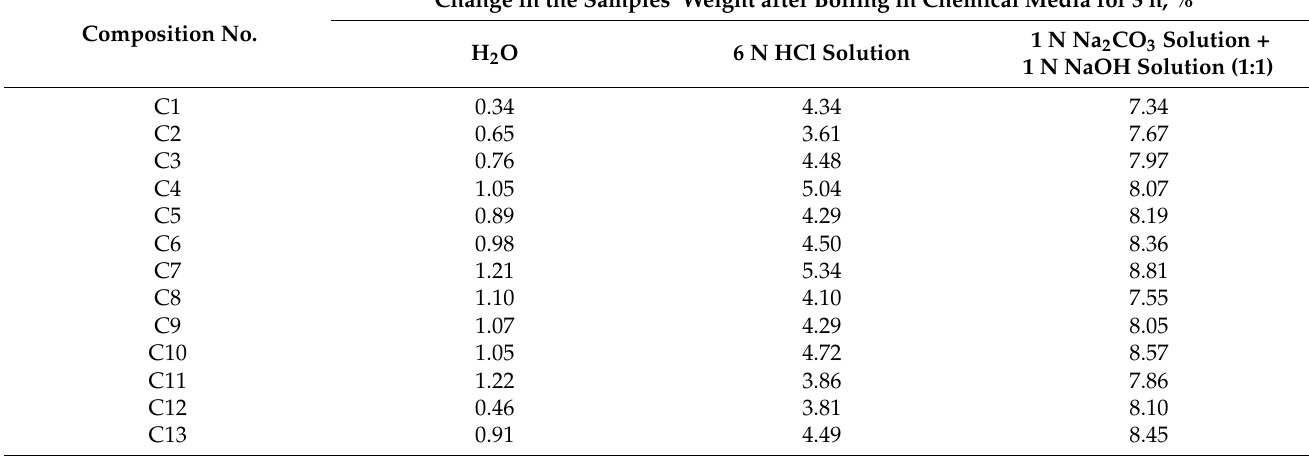
Table 2. Change in the samples’ weight after boiling in chemical media for 3 h. Change in the Samples’ Weight after Boiling in Chemical Media for 3 h, % Composition No.